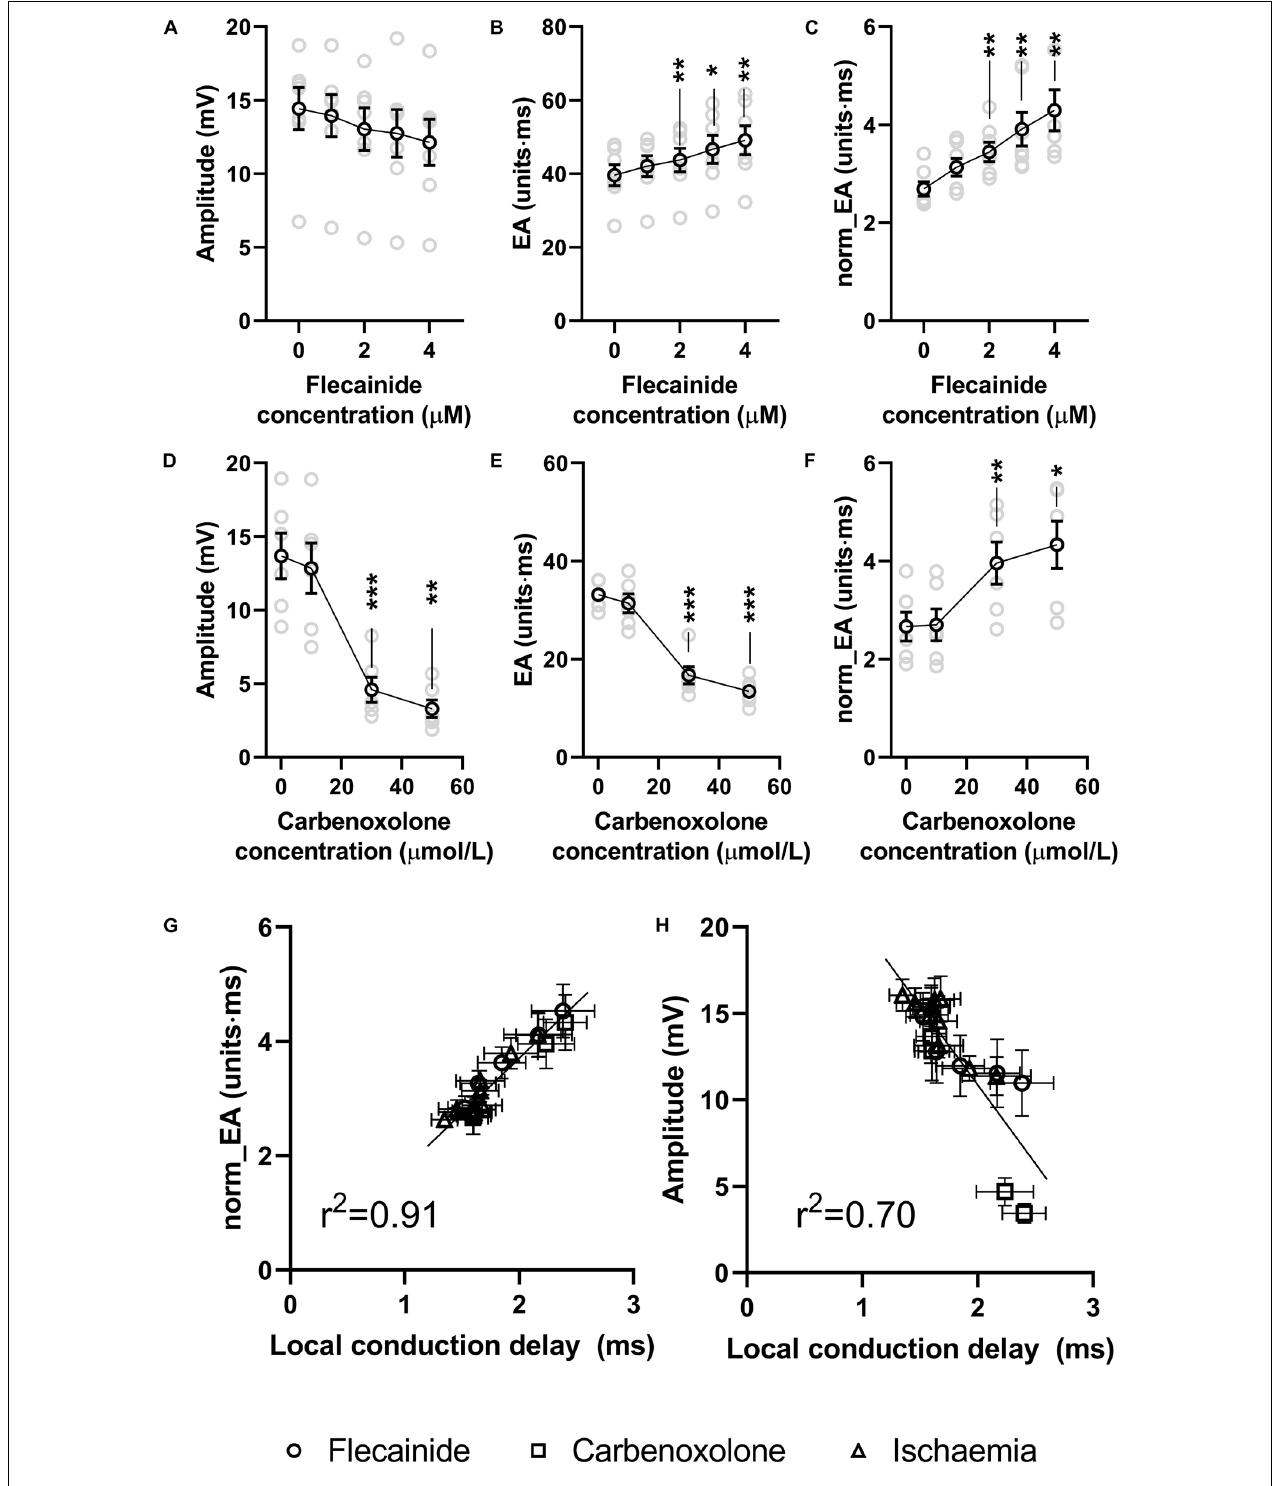
FIGURE 8 | Effects of sodium channel blockade and gap junction inhibition on electrogram morphology in isolated mouse hearts. (A–C) Data showing the effects of increasing concentrations of flecainide on bipolar electrogram amplitude, absolute electrogram area (EA) and normalized EA (norm_EA). (D–F) The same panels but for increasing concentrations of carbenoxolone. (G,H) Correlation between norm_EA and local activation delay (as assessed from the difference in activation time between adjacent electrodes/unipolar electrograms). Difference from 0 µ mol/L; * p < 0.05, ** p < 0.01, *** p < 0.001. Data are mean ± SEM. Actual replicates are shown in gray. n = 6,7 hearts per